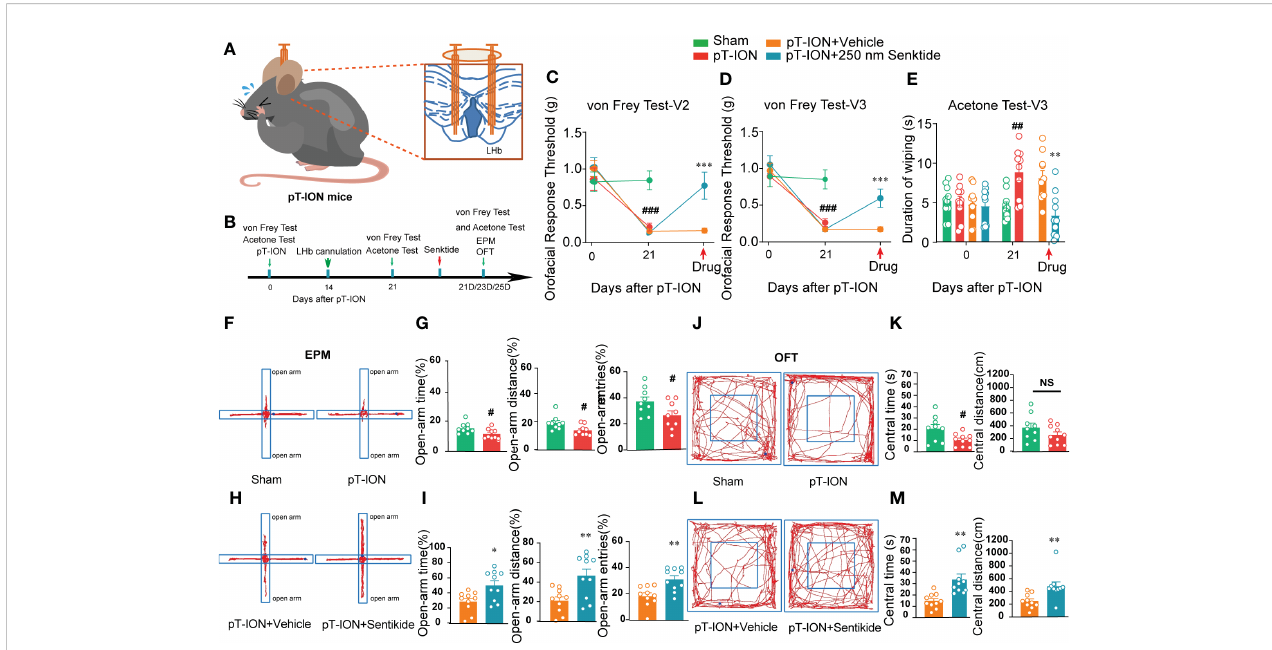
FIGURE 3 Bilateral injection of the NK3R agonist senktide into the LHb attenuated pT-ION-related allodynia and pain-associated anxiety-like behaviors. (A) Schematic of bilateral cannula implantation in the LHb of pT-ION mice. (B) The time schedule of the behavioral testing, pT-ION operation, cannulation, and drug administration. (C – E) pT-ION induced primary allodynia (C) and secondary allodynia (D) , as shown by reduced thresholds to mechanical stimuli, and secondary cold allodynia (E) was also induced in the V3 skin. The V2 and V3 mechanical allodynia and V3 cold allodynia were improved by bilateral senktide injection into the LHb (## p < 0.01, ###p < 0.001 vs. the sham group; **p < 0.01, *** p < 0.001 vs. the pT-ION+vehicle group; n = 10 mice per group). (F, H) Typical trajectories in the EPM. (G) The open-arm time, distance, and entries on day 21 after pT-ION were decreased (#p < 0.05, vs. the sham group, n = 10 mice per group). (I) The decreases in open-arm time, distance, and entries were completely reversed by bilateral senktide injection into the LHb (*p < 0.05, **p < 0.01 vs. the pT-ION+vehicle group, n = 10 mice per group). (J, L) Typical trajectories in the OFT. (K) The central times were decreased on day 21 after pT-ION while the central distance remained unchanged (#p < 0.05 vs. the sham group, n = 10 mice per group). (M) The central distance and central time were signi fi cantly increased by bilateral senktide injection into the LHb (**p < 0.01 vs. the pT-ION+vehicle group, n = 10 mice per group). NS, not signi fi